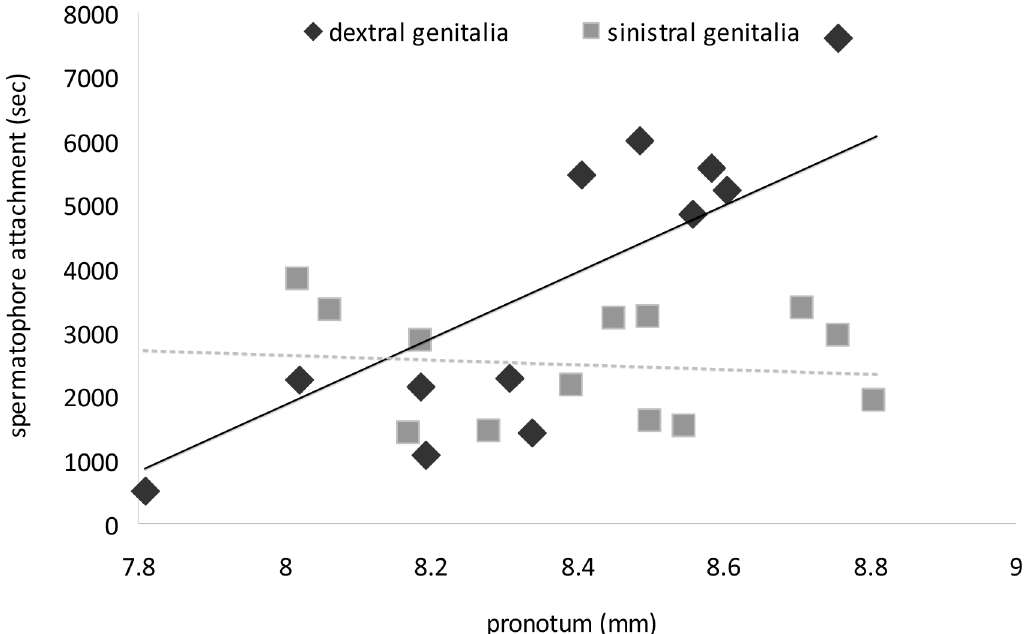
Fig 3. Relationship between male pronotum length (mm) and the duration of post-copulatory spermatophore attachment for sinistral (grey squares and dashed grey trendline: slope (y) = -537x; Pearson correlation: r = -0.159, n = 13, P = 0.604) and dextral (black diamonds and solid black trendline: slope (y) = 4989x; Pearson correlation: r = 0.582, n = 13, P = 0.037) male C . baldersoni .